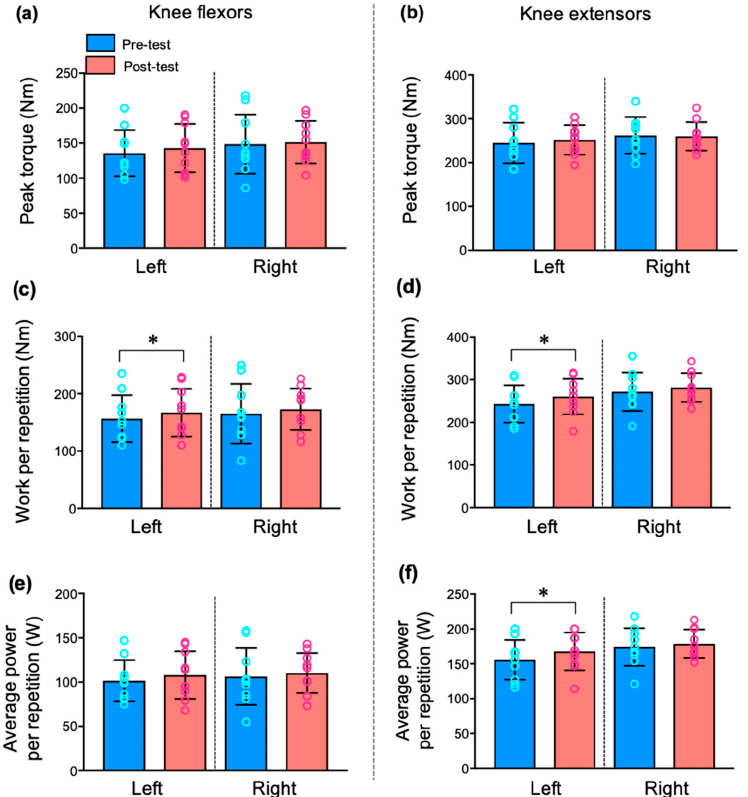
Figure 2. Change in isokinetic knee strength following 8-week Pilates training program. ( a , b ) There were no significant changes in peak torque of the knee flexor and extensors. ( c , d ) Work per repetition was increased in left knee flexor ( p < 0.05) and extensors ( p < 0.05). ( e , f ) Average power per repetition was increased in left knee extensors ( p < 0.05). All values are presented as mean ± SD (n = 11). Note: * p < 0.05, vs. pre-test.